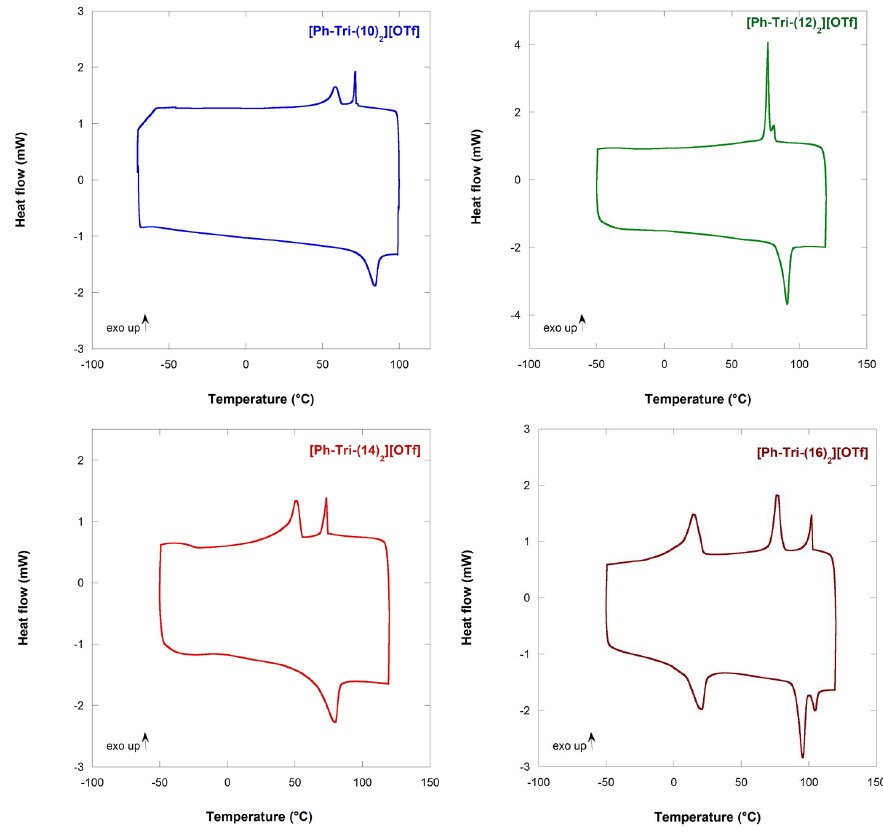
Figure 1. DSC traces of ILCs showing the second cooling and heating cycles. Exothermic peaks point upward. Table 2. Transition temperatures (T), enthalpies ( Δ H) and phase transition of the salts obtained from DSC traces upon cooling.